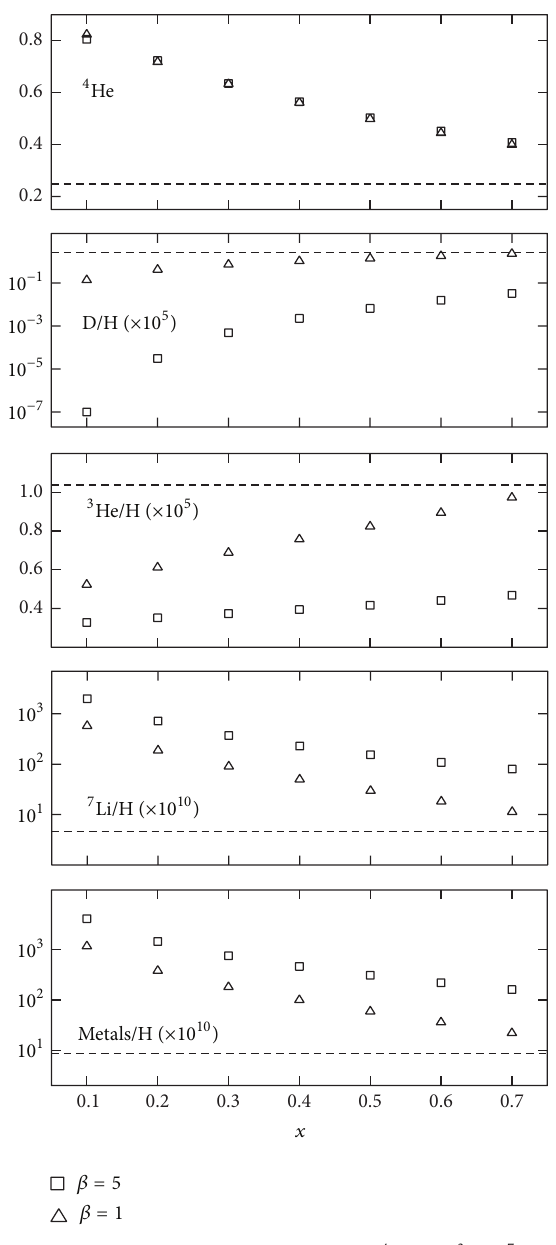
Figure 2: Primordial abundances of mirror 4 He, D, 3 He, 7 Li, and metals (elements heavier than 4 He) for several values of 𝑥 and two different 𝛽 andcomparedwiththepredictionsofthestandardmodel (dashed